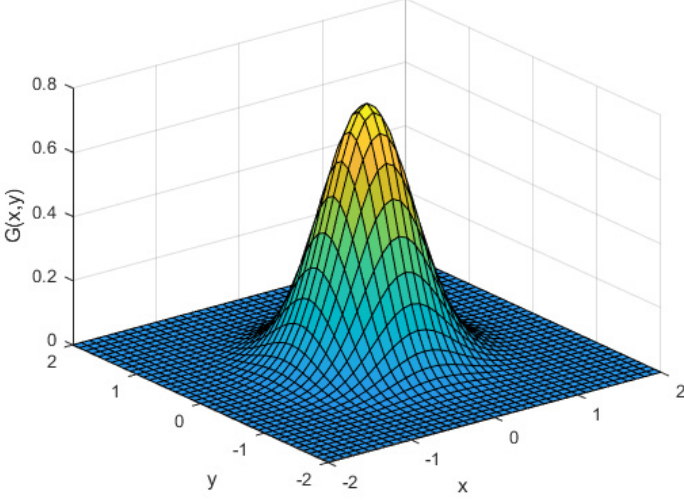
Figure 3. Gaussian function plot.